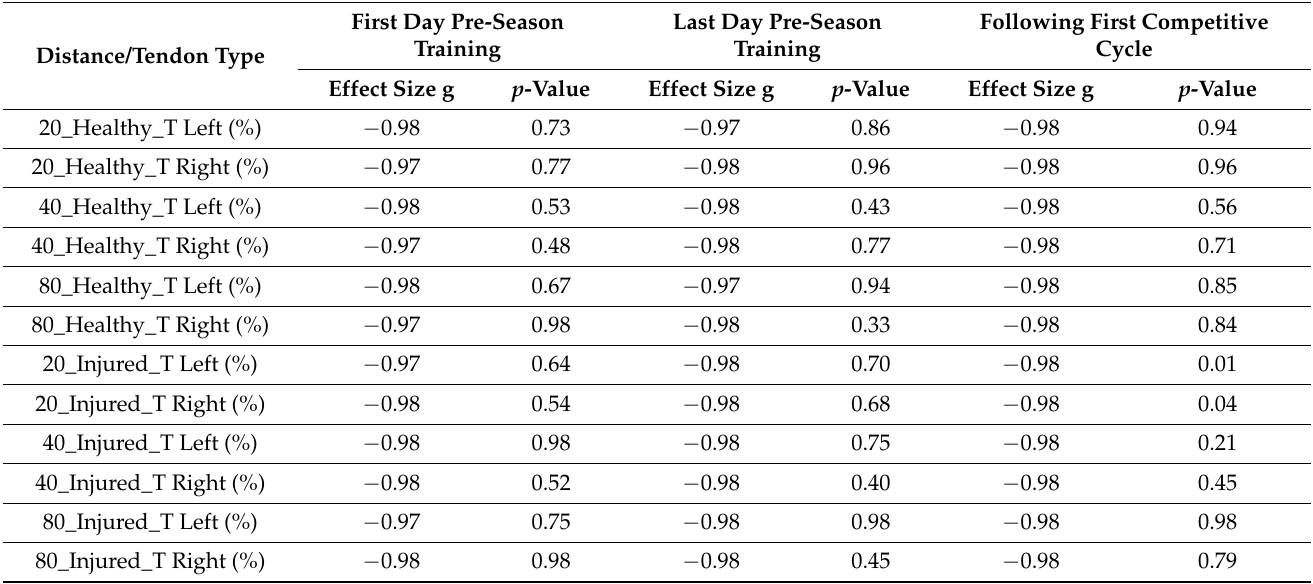
Table 3. Association between tendon structure and jumping performance (CMJ) (Hedges’ g effect size and p -value) at the first and last day of pre-season training and following the first competitive cycle. Association between Tendon Structure and CMJ (Mean Right and Left) First Day Distance/Tendon Type